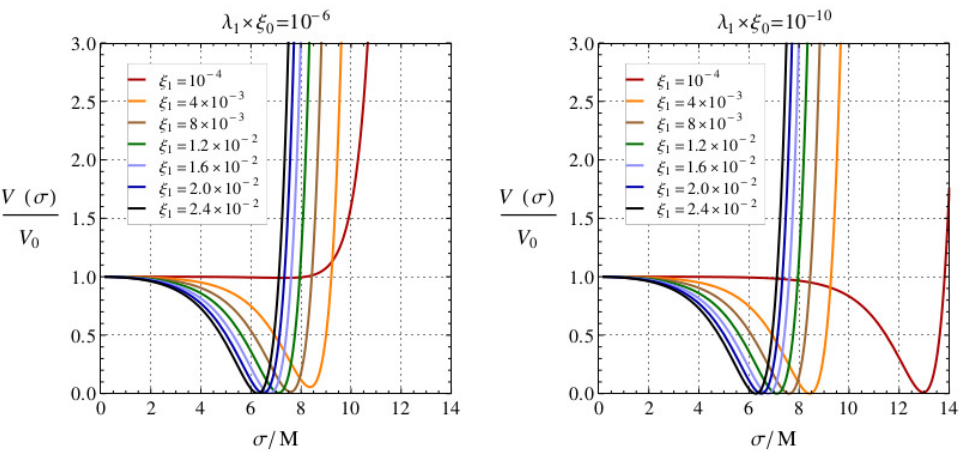
p (cid:24) while its height is V 0 / 1 =(cid:24) 0 . 1